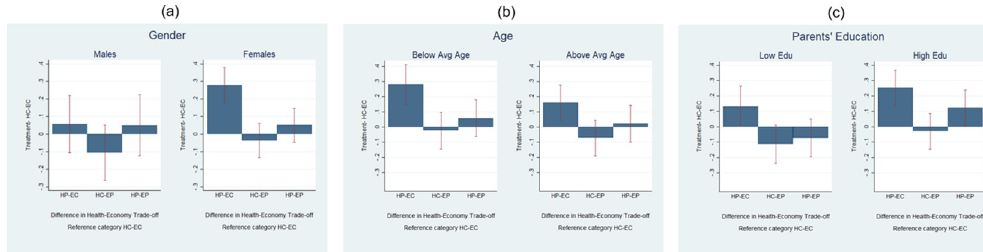
Fig 2. Predetermined characteristics and background.